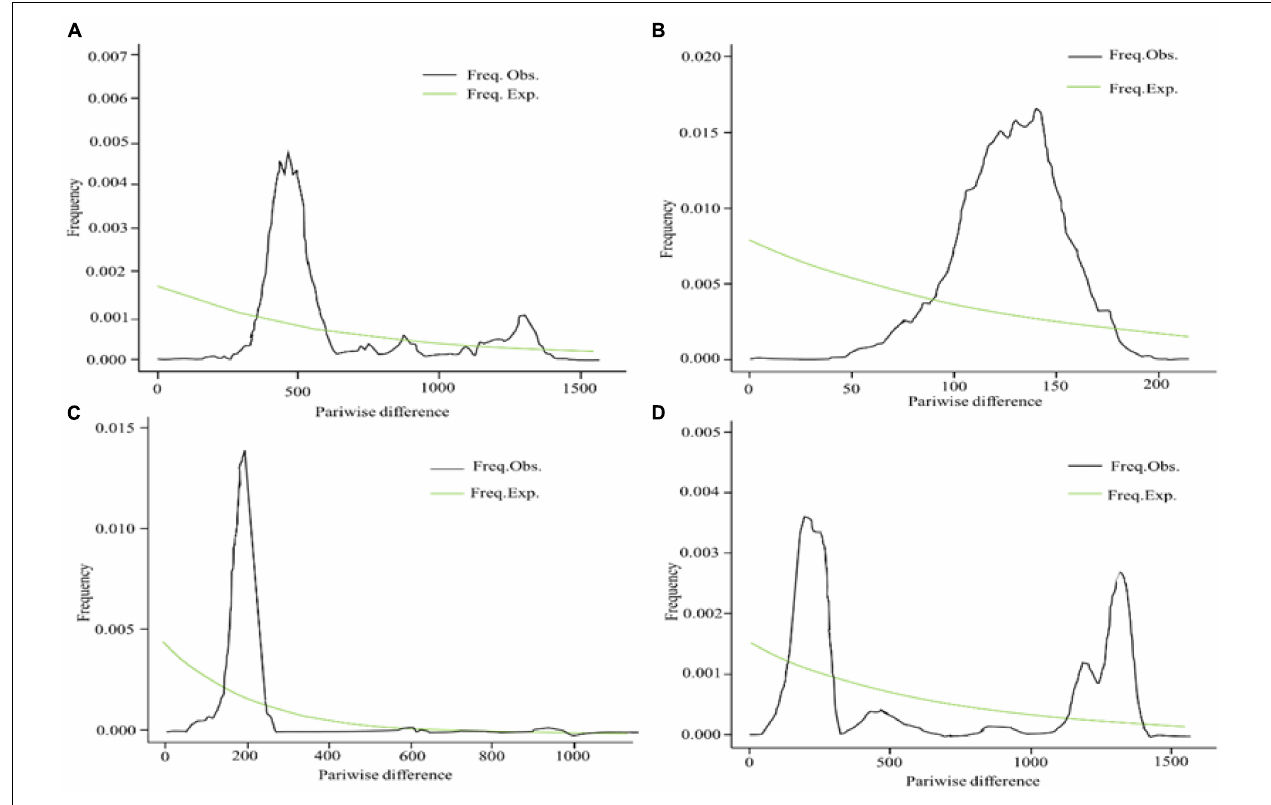
FIGURE 10 | Results of effective population size inference for three groups.